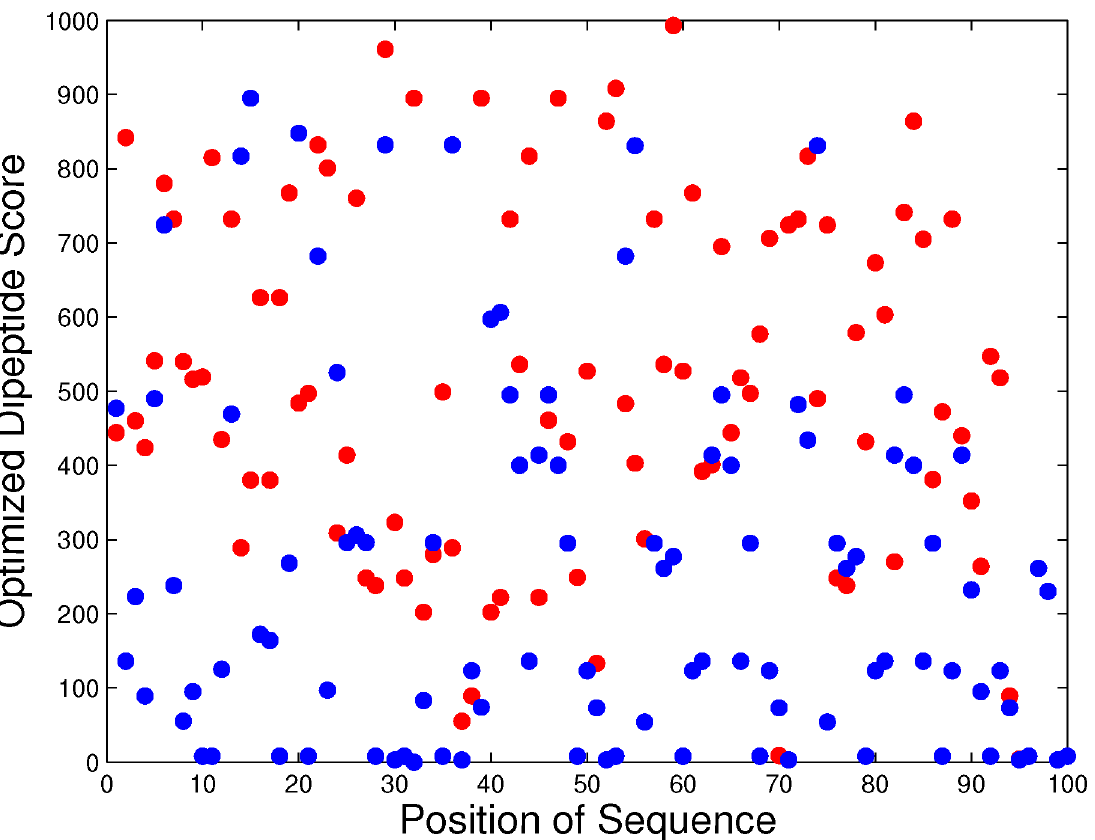
Figure 4. Distribution of dipeptide scores on two typical sequences of BLPs. The BLP with Pfam ID A8QZJ6 (length 96 with domain Oxidored shown in red) and the non-BLP with NCBI sequence entry GI: 20137223 (length 101 shown in blue) have high and low sequence scores 551.65 and 256.86, respectively.